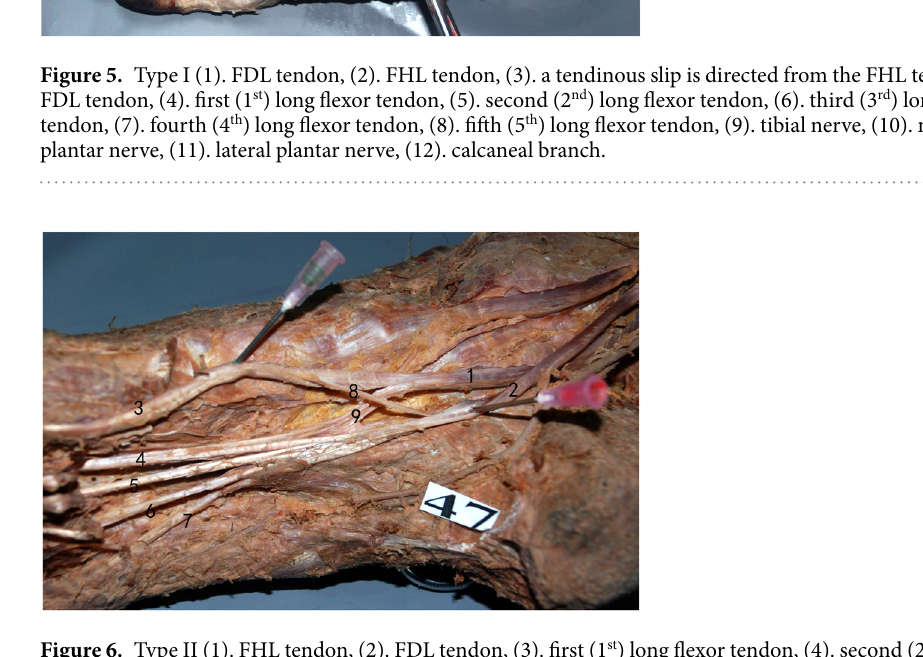
Figure 6. Type II (1). FHL tendon, (2). FDL tendon, (3). first (1 st ) long flexor tendon, (4). second (2 nd ) long flexor tendon, (5). third (3 rd ) long flexor tendon, (6). fourth (4 th ) long flexor tendon, (7). fifth (5 th ) long flexor tendon, (8). tendinous slip from FDL to FHL, and (9). tendinous slip from FHL to